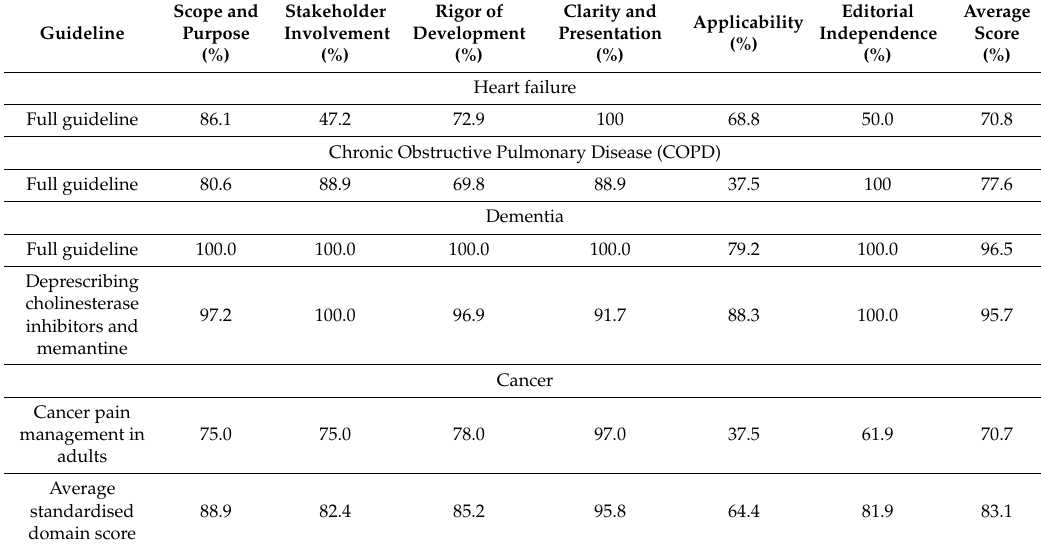
Table 3. AGREE II scores per domain for individual